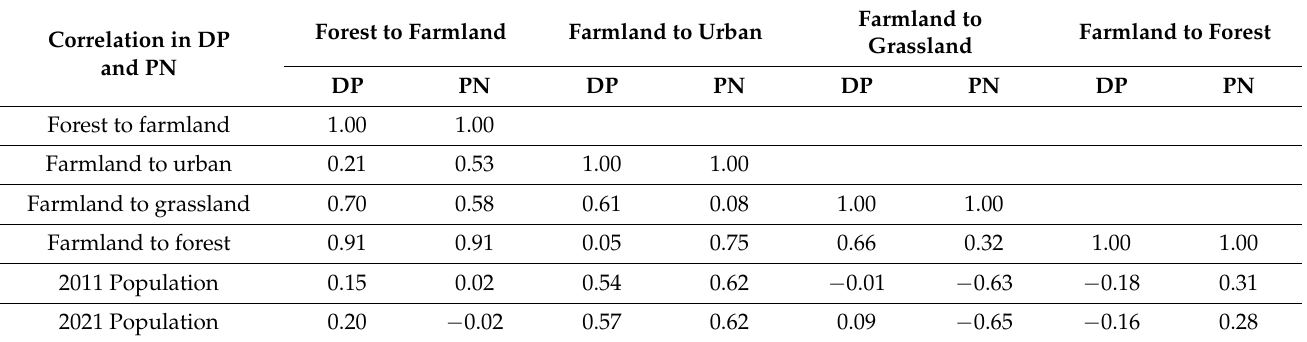
Table 3. Correlation matrix of different LCC types’ contributions between multiple scales. DP means the correlation in district to province and PN means the correlation in province to nation.